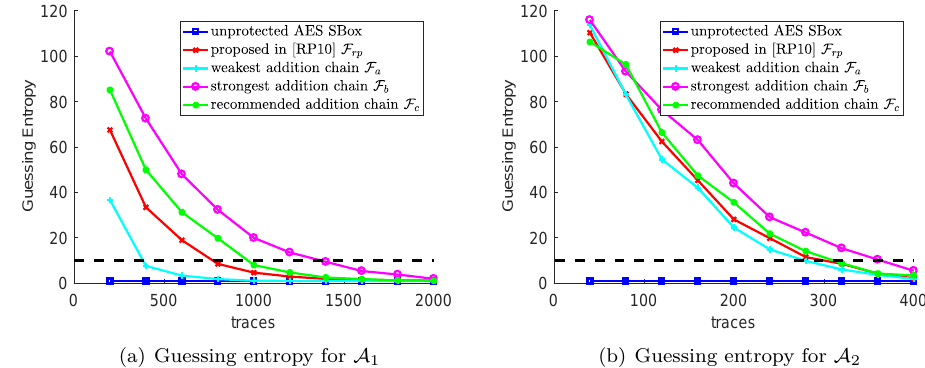
Figure 9: The results of third-order CPA on four different second-order masked addition chain